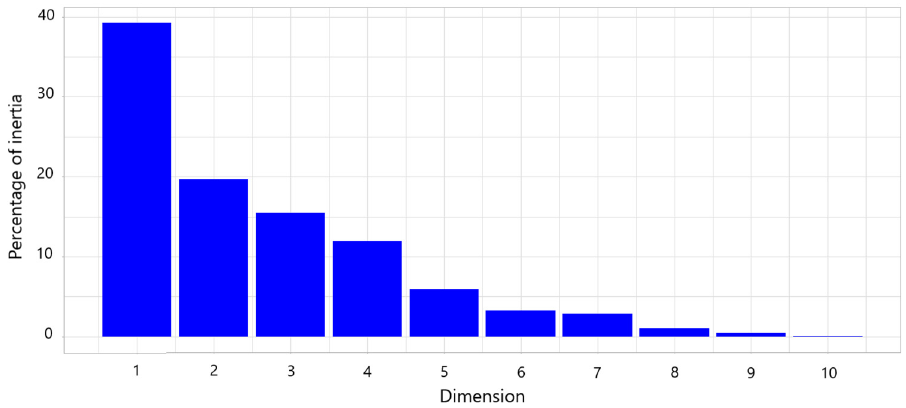
Figure 12. The total inertia decomposition of PCA